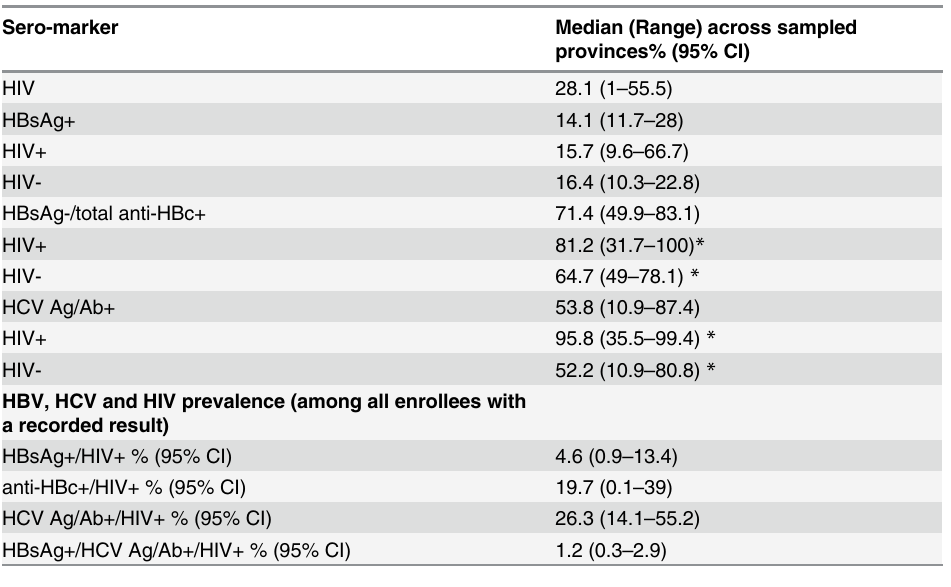
Fig 1. Provincial level correlation * of HIV to HBsAg, total anti-HBc, and HCV in the 2009 IBBS. Table 2. HIV, hepatitis B virus (HBV), hepatitis C virus (HCV), and co-infection prevalence.